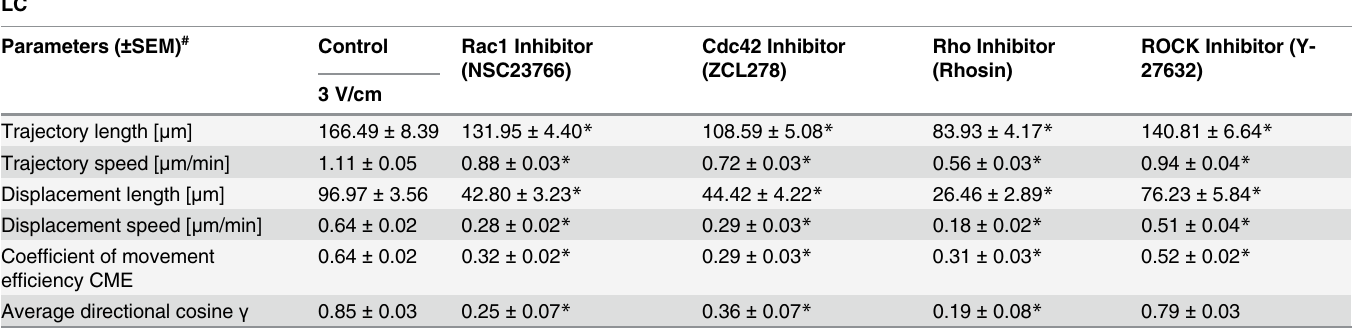
Table 5. Quantitative data showing the effects of Rac, Cdc42, Rho and ROCK inhibitors on electrotaxis of LC